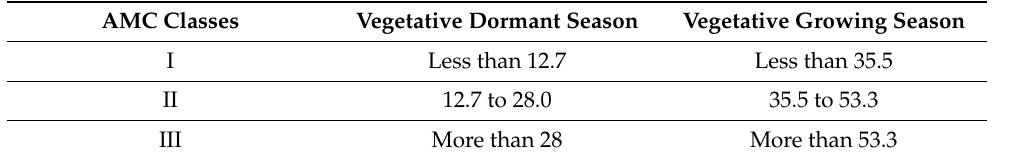
Table 2. AMC classes [34].